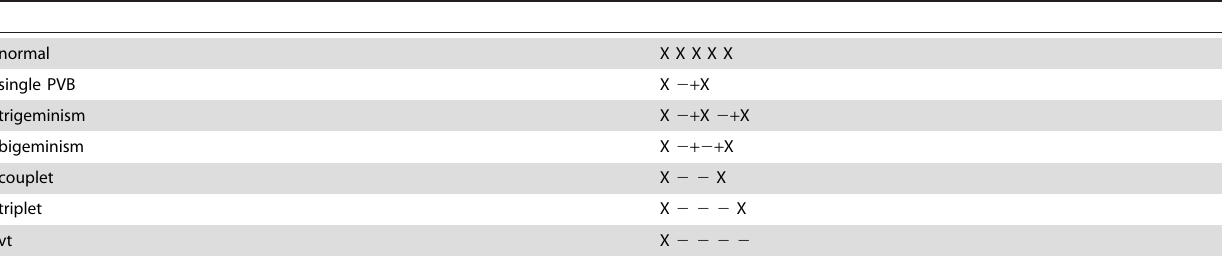
Table 1. Specific sequences of interspike interval (ISI) define normal or abnormal behavior; X normal ISI; 2 , shorter than normal; + , longer than